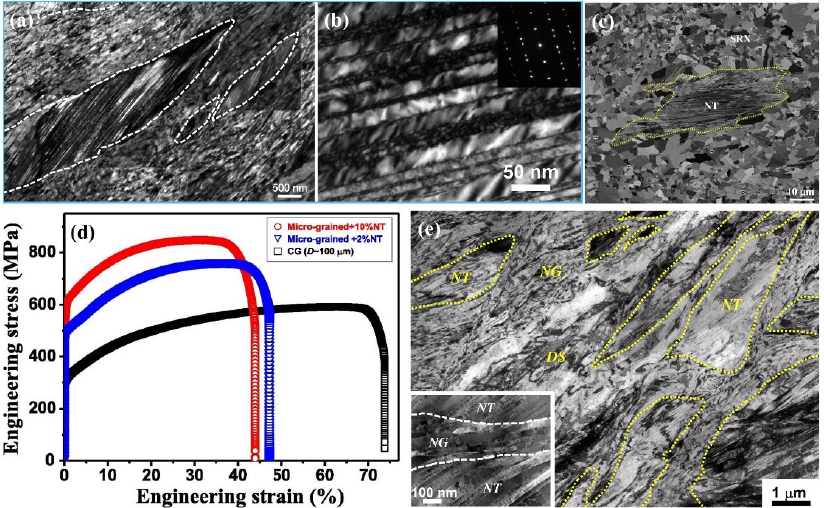
Figure 3. ( a , b ) TEM image of DPD 316L austenitic SS (the NT bundles are enclosed by white dash lines), inset in ( b ) is the corresponding selected area electron diffraction (SAED) pattern [73]; ( c ) scanning electron microscopy (SEM) image of the DPD 316L austenitic stainless after annealed (the NT and SRX refer to nanotwins and static recrystallization grains, respectively) [74]; ( d ) tensile engineering stress–strain curves of austenite 316L steels containing 10 and 2 vol.% of NT ‐γ grains [93]; ( e ) bright ‐ field TEM image of DPD Cu–Ag sample, inset is the scanning transmission electron microscope ‐ high angle annular dark field (STEM ‐ HAADF) image of the DPD sample , the labeled NT and the areas circled by yellow dotted lines, NG, and DS refer to nanotwins, nanograins, and dislocation structures, respectively [65].